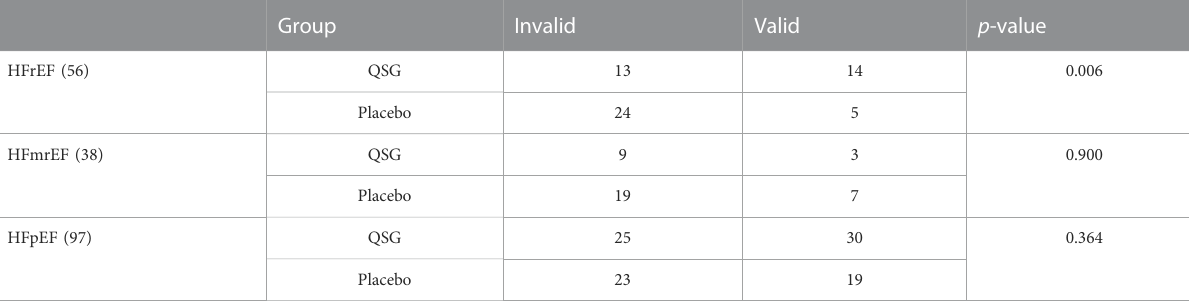
TABLE 5 subgroup Treatment ef fi ciency in NT-proBNP. Group